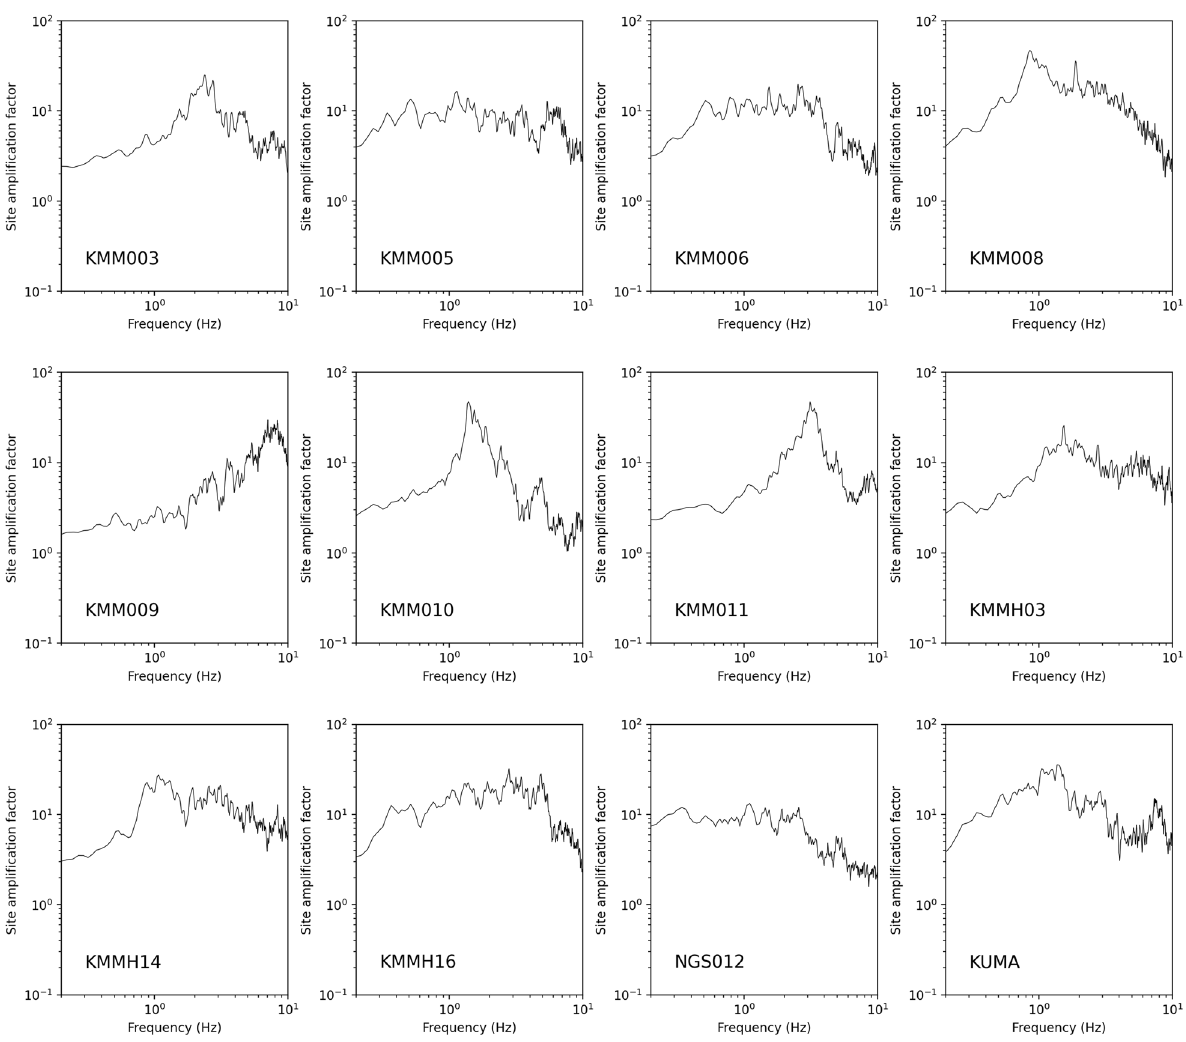
Fig. 4 Inverted site amplification factors. Black lines indicate the site amplification factors estimated by the spectral inversion in this study